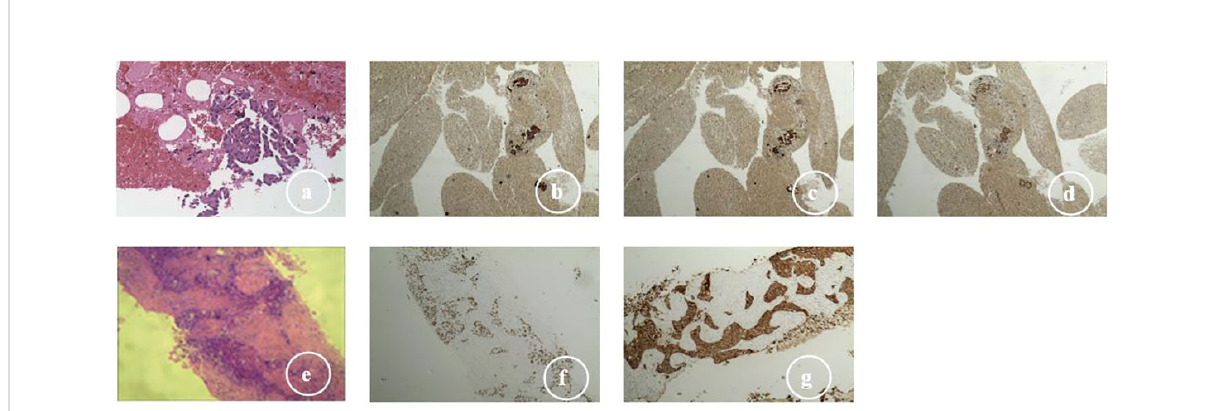
FIGURE 2 Histologic transformation from adenocarcinoma to squamous cell carcinoma: (A) lymph node specimens (EBUS-TBNA), adenocarcinoma (H&E, ×200); (B) adenocarcinoma CK7 (+); (C) adenocarcinoma TTF; (+) (D) adenocarcinoma NapsinA (+); (E) lung biopsies (CT-guided sampling), squamous cell carcinoma (H&E, ×400); (F) squamous cell carcinoma P40 (+); (G) squamous cell carcinoma CK5/6